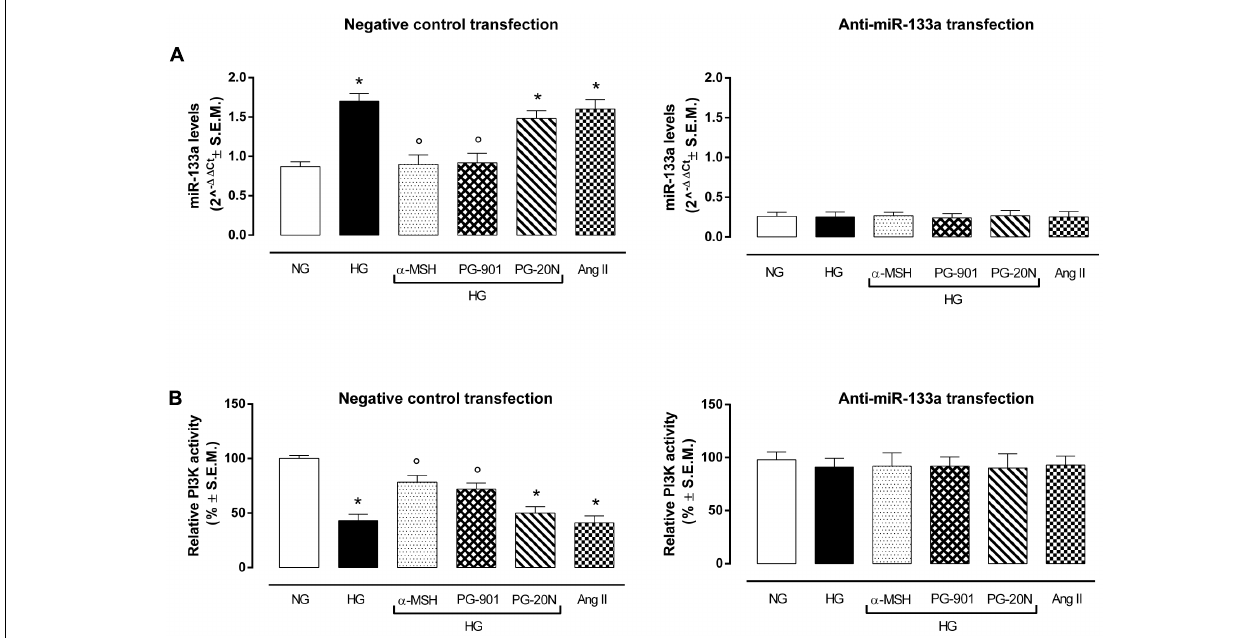
FIGURE 6 | miR-133a levels and PI3K activity. (A) H9c2 cells exposed to high glucose (33 mM D -glucose) and transfected with negative control miRNA inhibitor showed increased miR-133a levels compared to cell exposed to normal glucose (5.5 mM D -glucose). a-MSH (90 pM) and PG-901 (10 − 10 M) significantly decreased miR-133a levels, while PG-20N antagonist didn’t modify miR-133a expression. As expected, miR-133a knockdown abolished this differential expression pattern in our experimental setting. Values are expressed as mean of 2 − (cid:49)(cid:49) Ct ± S.E.M. of n = 3 independent experiments, performing each treatment in triplicate in a single experiment. (B) Fitting with these evidences, PI3K activity was decreased in H9c2 cells exposed to high glucose, but it was significantly reverted by a-MSH (90 pM) and PG-901 (10 − 10 M).miR-133a knockdown reverted PI3K activity to values expressed by control cells in all the experimental conditions. Values are expressed as mean ± S.E.M. of n = 9 values, obtained from the triplicates of three independent experiments. NG, normal glucose; Ang II, angiotensin II; HG, high glucose; ∗ P < 0,01 vs. NG; ◦ P < 0,01 vs.